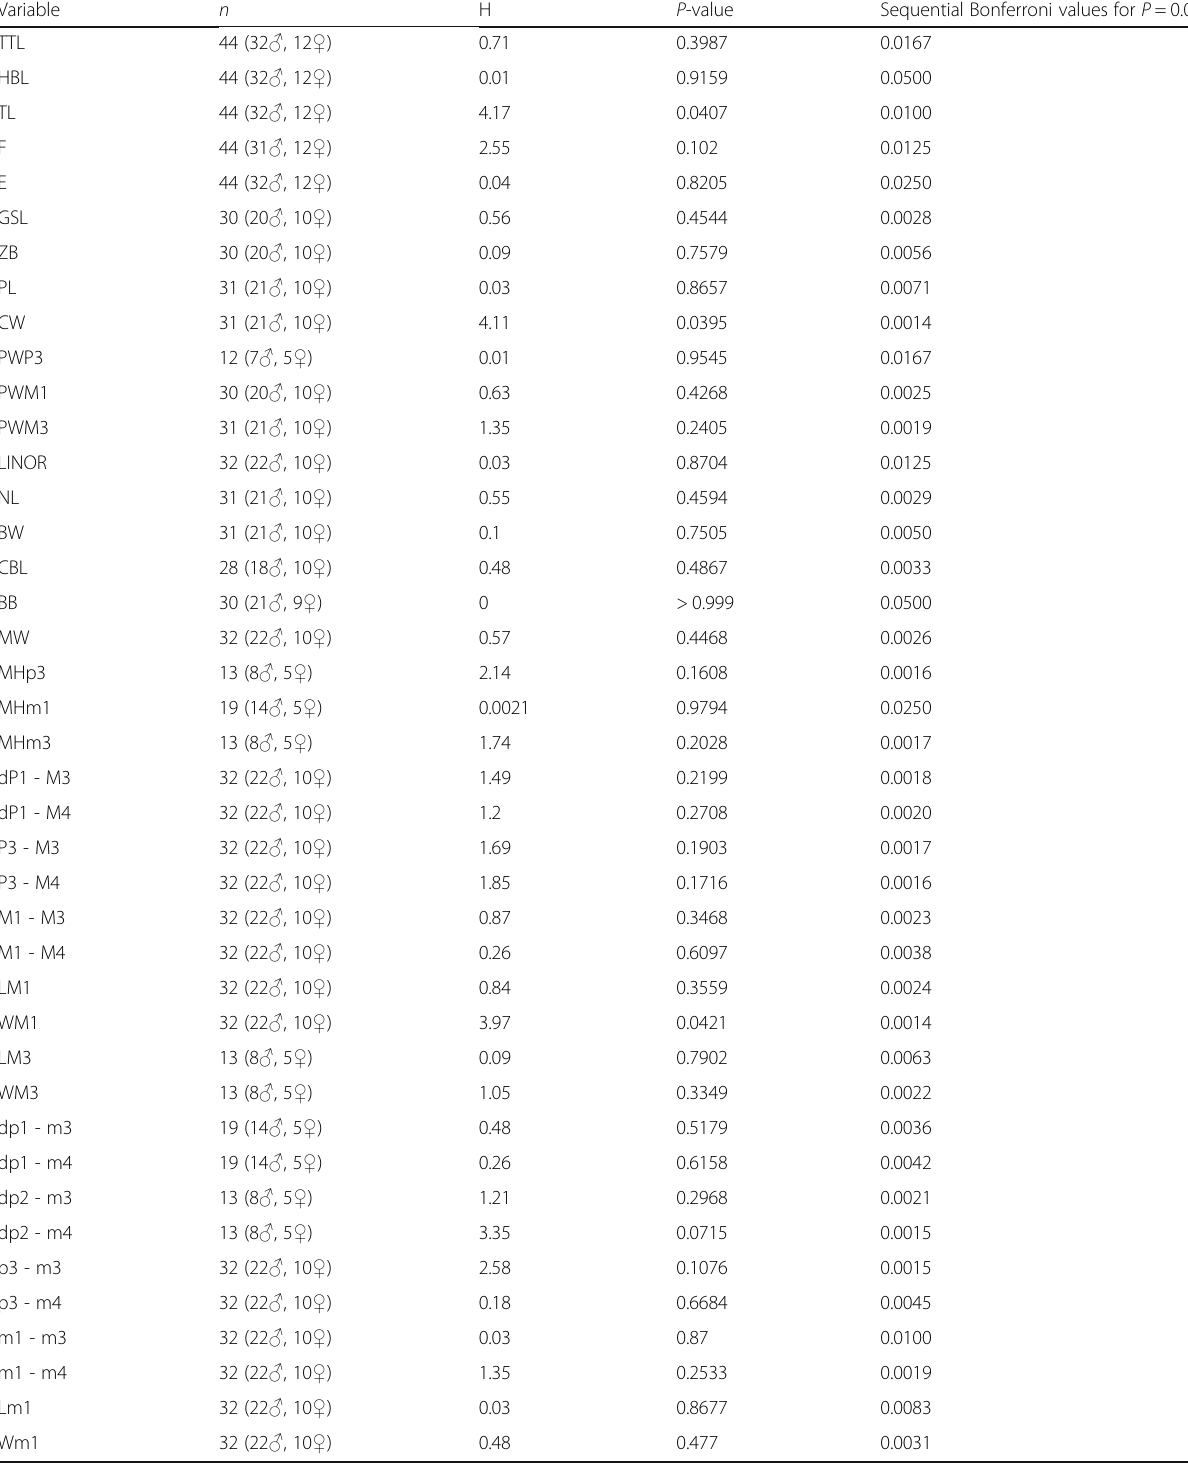
Table 3 Results of a non-parametric Kruskal – Wallis analysis of variance (ANOVA), calculated from Mosimann ’ s variables, for differences between males and females of Rhyncholestes raphaunurus Osgood, for La Picada (Chile), the locality with the largest number of specimens. Total number of specimens ( n ), and specimens by sex (between brackets) are indicated for each measurement. Asterisks mark significant differences (if existent) for sequential Bonferroni-corrected values, following Rice [39].